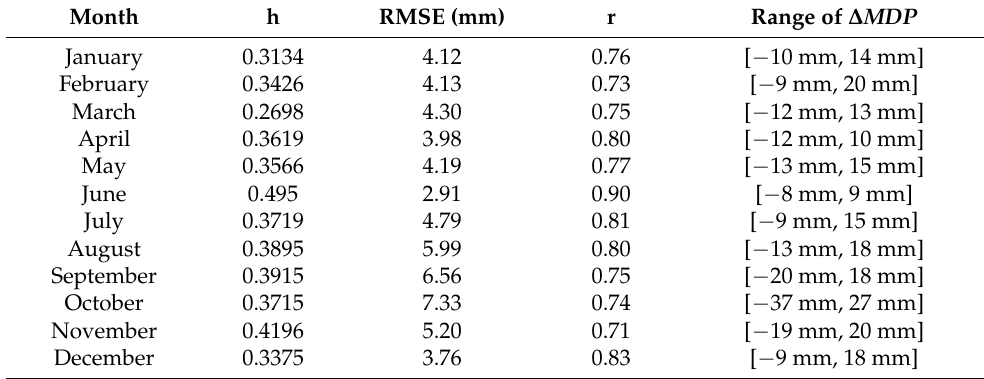
Figure 11. Scatter plots and the best-fit lines of monthly precipitation (MP) vs. the maximum daily precipitation of each month. Table 5. Statistics of the linear regression of MP vs. MDP